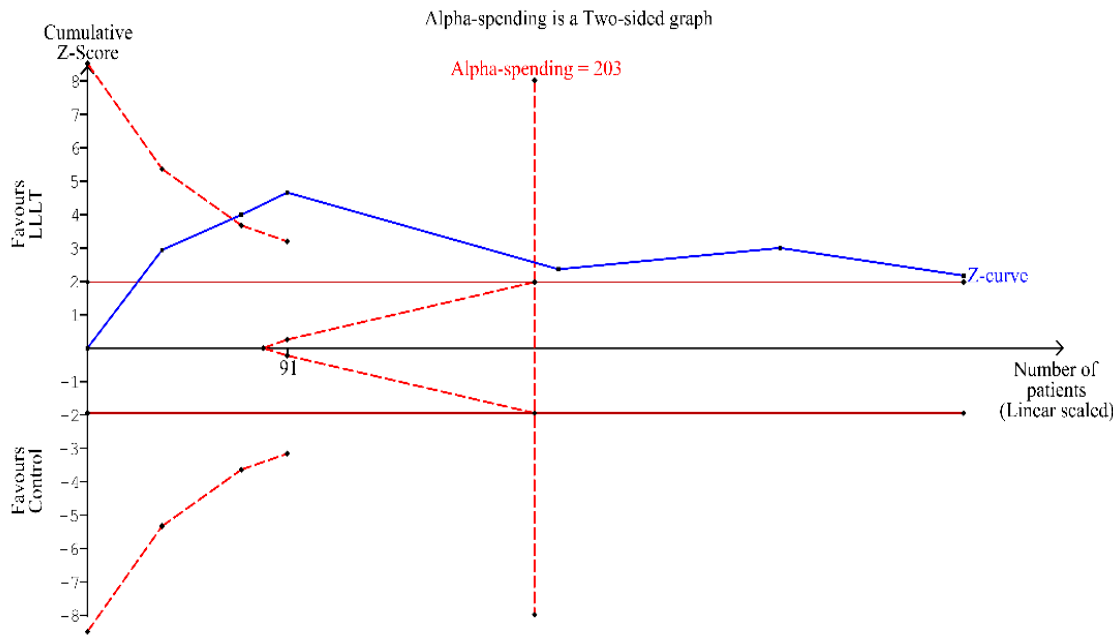
Figure 5. Trial sequential analysis evaluating the therapeutic benefit of PBM in inducing partial clinical resolution of OM using random-effects meta-analysis.